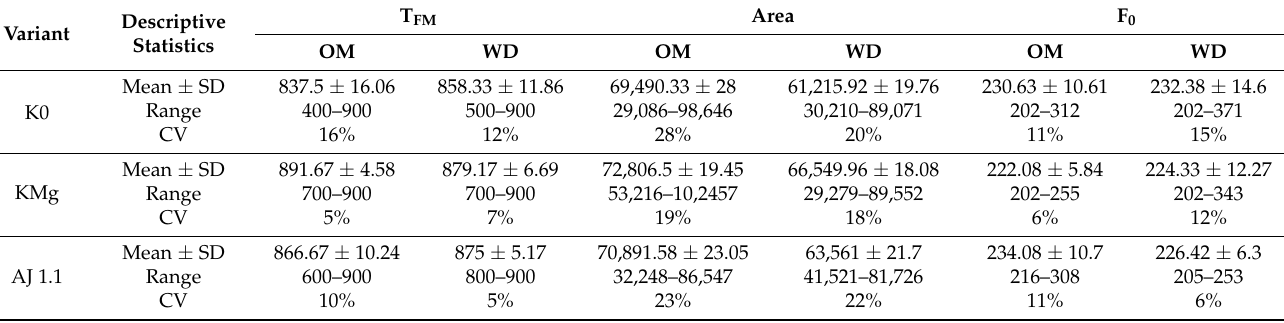
Table 2. Descriptive statistics